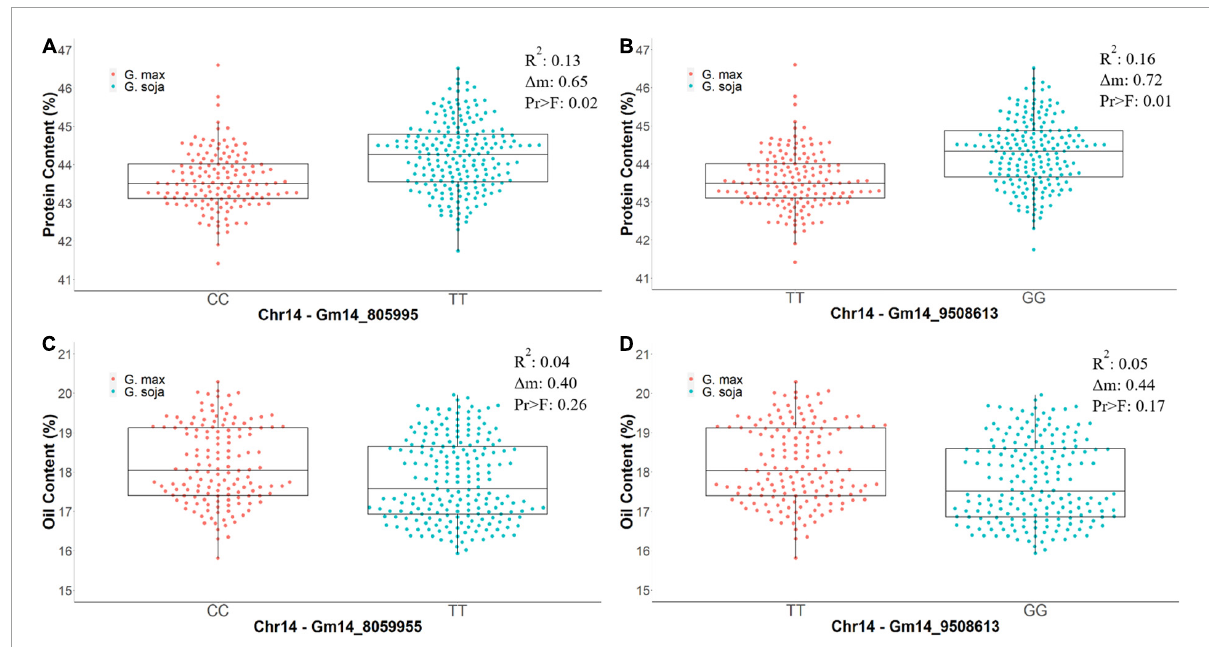
FIGURE5 The differences in phenotypic values of protein content (%) and oil content (%) from CLM&NOV carrying different homozygous alleles for the markers Gm14_8059955 and Gm14_9508613. Allele (CC) is the allele from G. max (Osage) and (TT) is the allele from G. soja (PI 593983) in Gm14_8059955. The alleles in Gm14_9508613 are (TT) for G. max (Osage) and (GG) for G. soja (PI 593983). (A) Protein content for Gm14_8059955. (B) Protein content for Gm14_9508613. (C) Oil content for Gm14_8059955. (D) Oil content for Gm14_9508613. The whiskers represent the maximum and minimum values, the box displays the 25th and 75th percentile, and the line in the box is the median value. The dots represent the density of the phenotypic values.